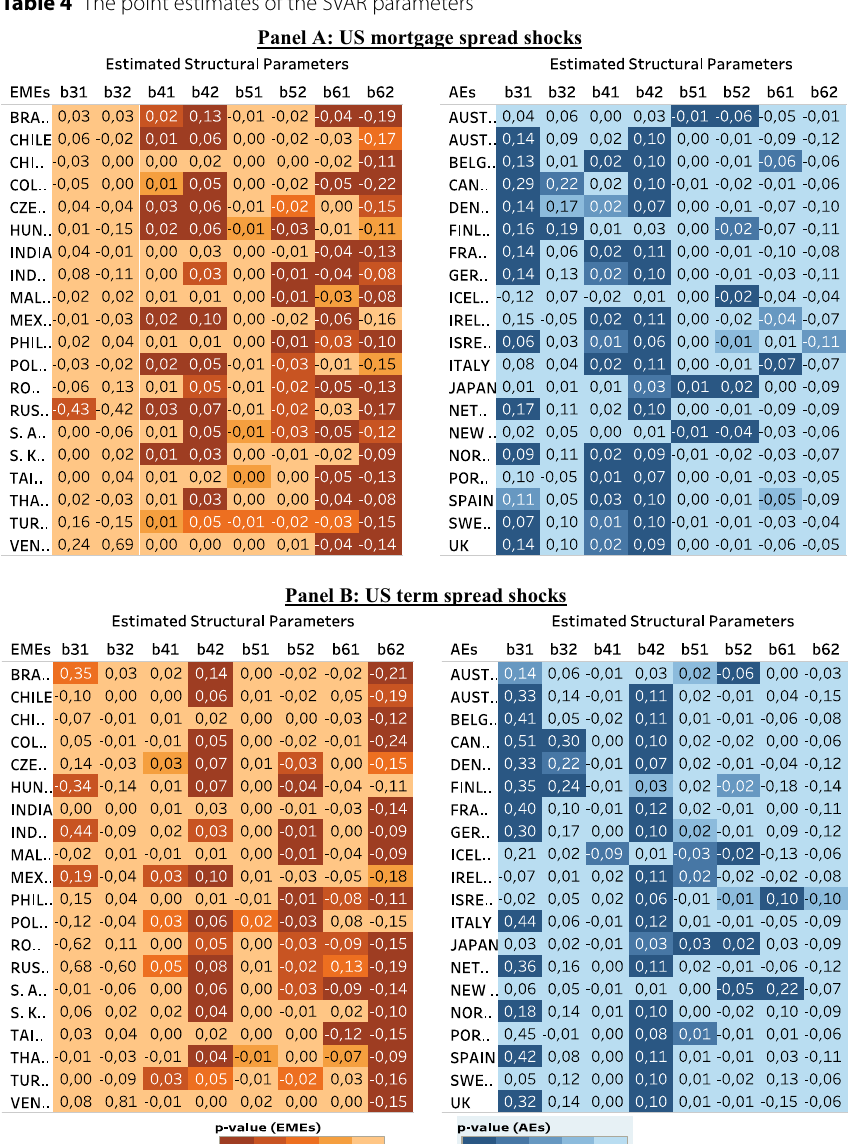
Table 4 The point estimates of the SVAR